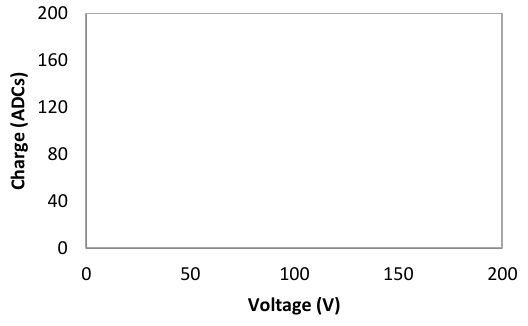
Fig. 5. The plot shows how the charge collected, in ADC counts, increases with bias voltage till a plateau is reached when the sensor is fully depleted.